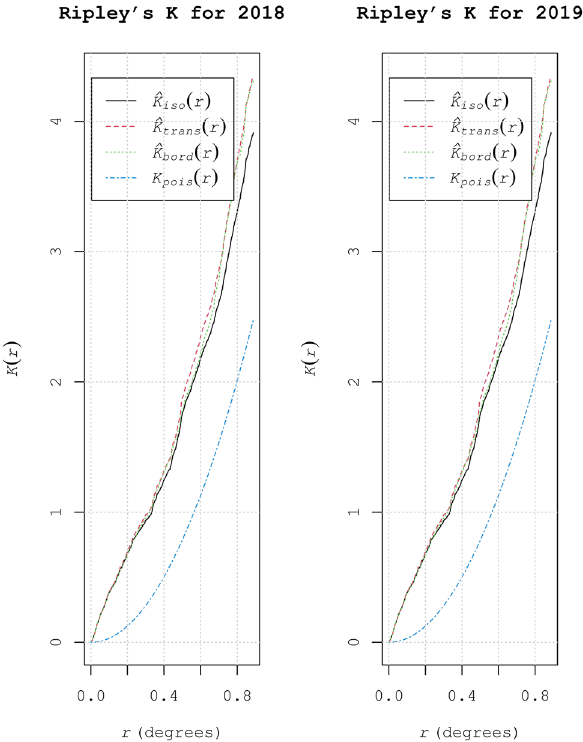
Figure 5. Ripley’s K function values for different sampling sites exhibiting the spatial patterns of RBD in Karnataka during 2018 and